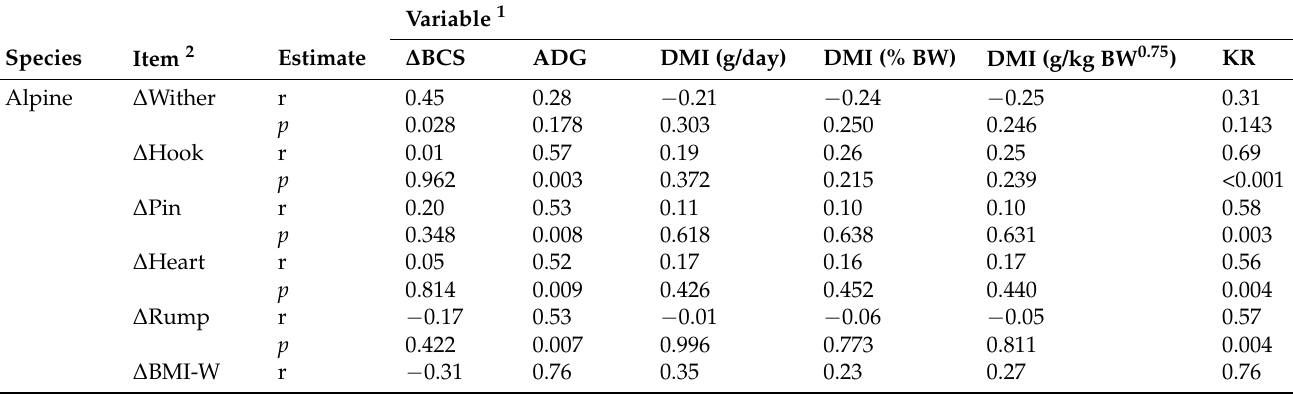
Table 6. Pearson correlation coefficients (r) between change ( ∆ ) in body condition score, average daily gain, dry matter intake, and Kleiber ratio and change ( ∆ ) in linear measures and body mass indexes during the